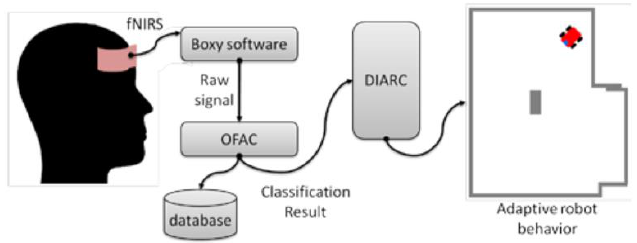
Figure 3. The proof-of-concept Brain-based Adaptive User Interface Platform Figure 3 . The proof-of-concept Brain-based Adaptive User Interface Platform [19].